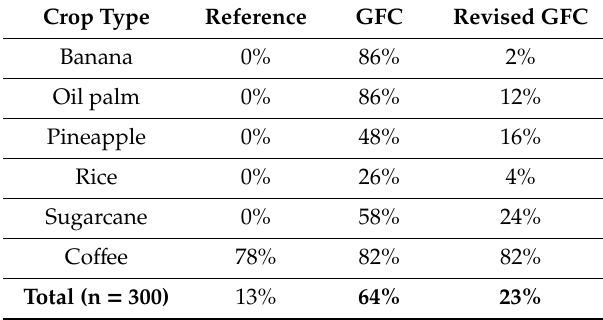
Table 4. Tree cover predicted by the GFC (updated to 2015) and corrected GFC in agricultural areas. The percentage of agricultural reference points with tree cover > 0% is shown, drawing from the agricultural training dataset as a reference (n = 300). Percentages were calculated for individual crops (n =